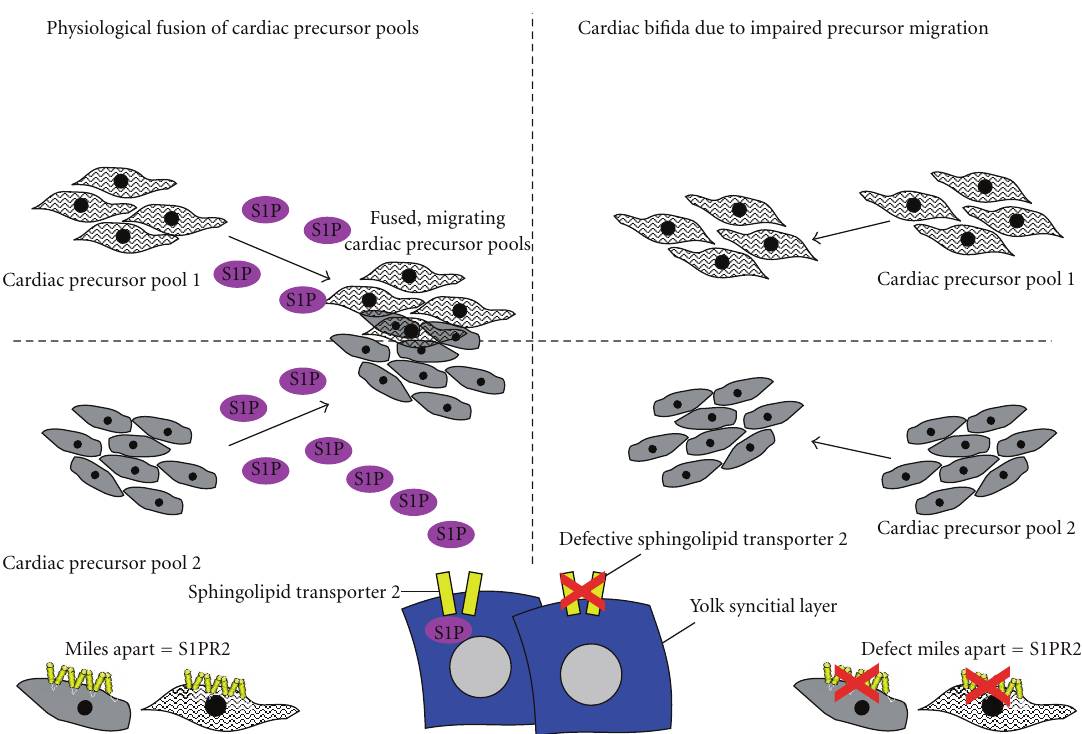
Figure 4: In vivo model of S1P function and its respective cofactors in the developing